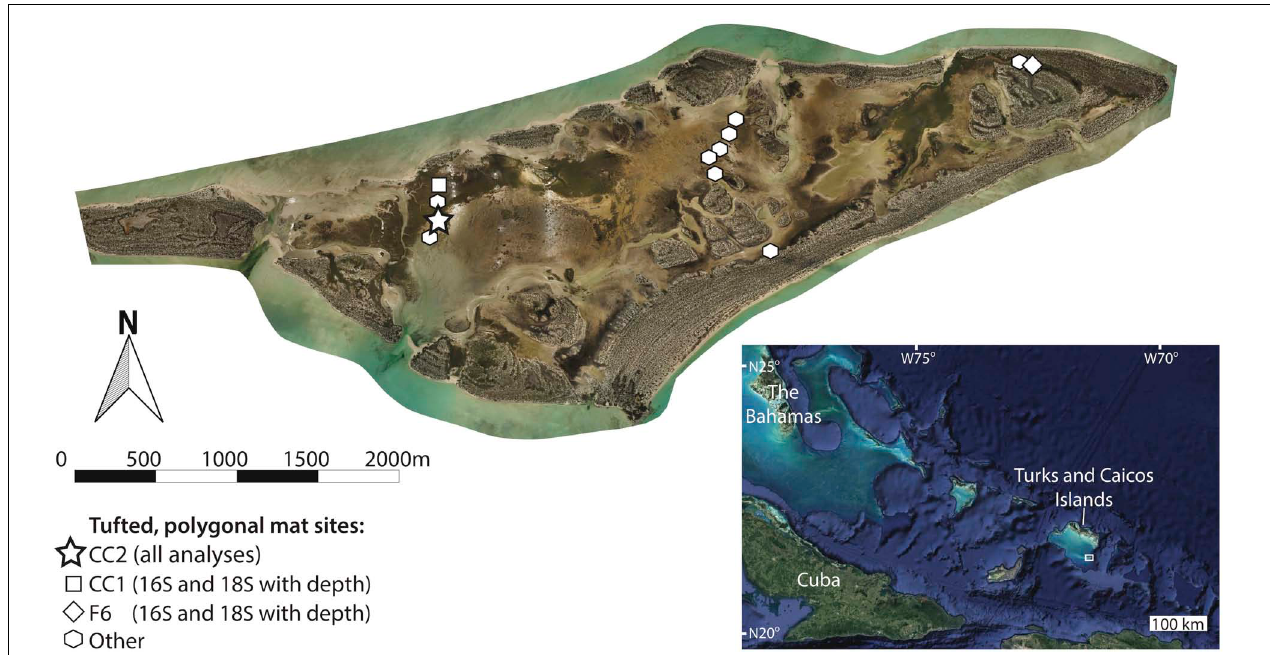
FIGURE 1 | Orthomosaic of Little Ambergris Cay (Stein et al., 2016, online image reprinted with permission, retrieved from http://www.ntstein.com/home/little-ambergris/) with locations of tufted, polygonal microbial mat study sites. Microbial mats are found in shallow bays and channels that line the interior of the island, which is surrounded by an oolitic grainstone rim. The bottom right inset image shows the location of the Turks and Caicos Islands within the southwest north Atlantic Ocean (image from Google Earth; map data from SIO, NOAA, U.S. Navy, NGA, GEBCO; image from Landsat/Copernicus) with a box around the location shown in the main image. We conducted all analyses on the site CC2 (star), characterized by polygonal mats. Sites used for analyses of depth trends in 16S and 18S data are shown with a square (CC1) and a diamond (F6). Other polygonal mat sites, from which pigment-rich layers were sampled for 16S analysis, are indicated with polygons. Additional information about site locations and metadata are provided in Supplementary Table S1